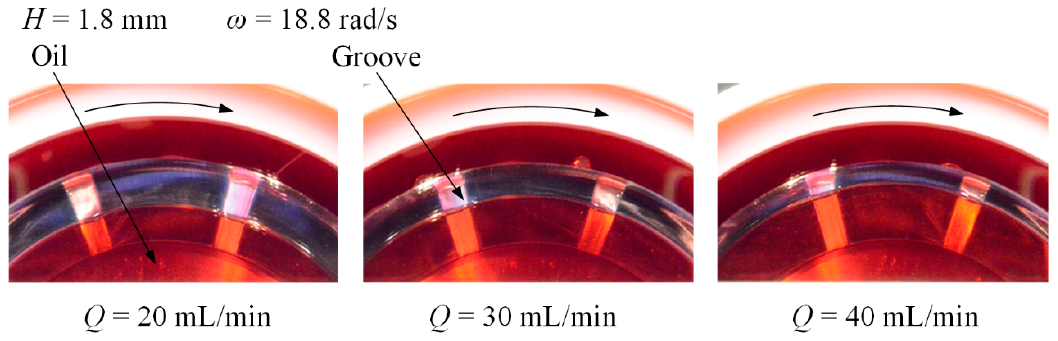
Figure 9. Comparison of the air–oil interface radial position with different inlet oil flow rates.